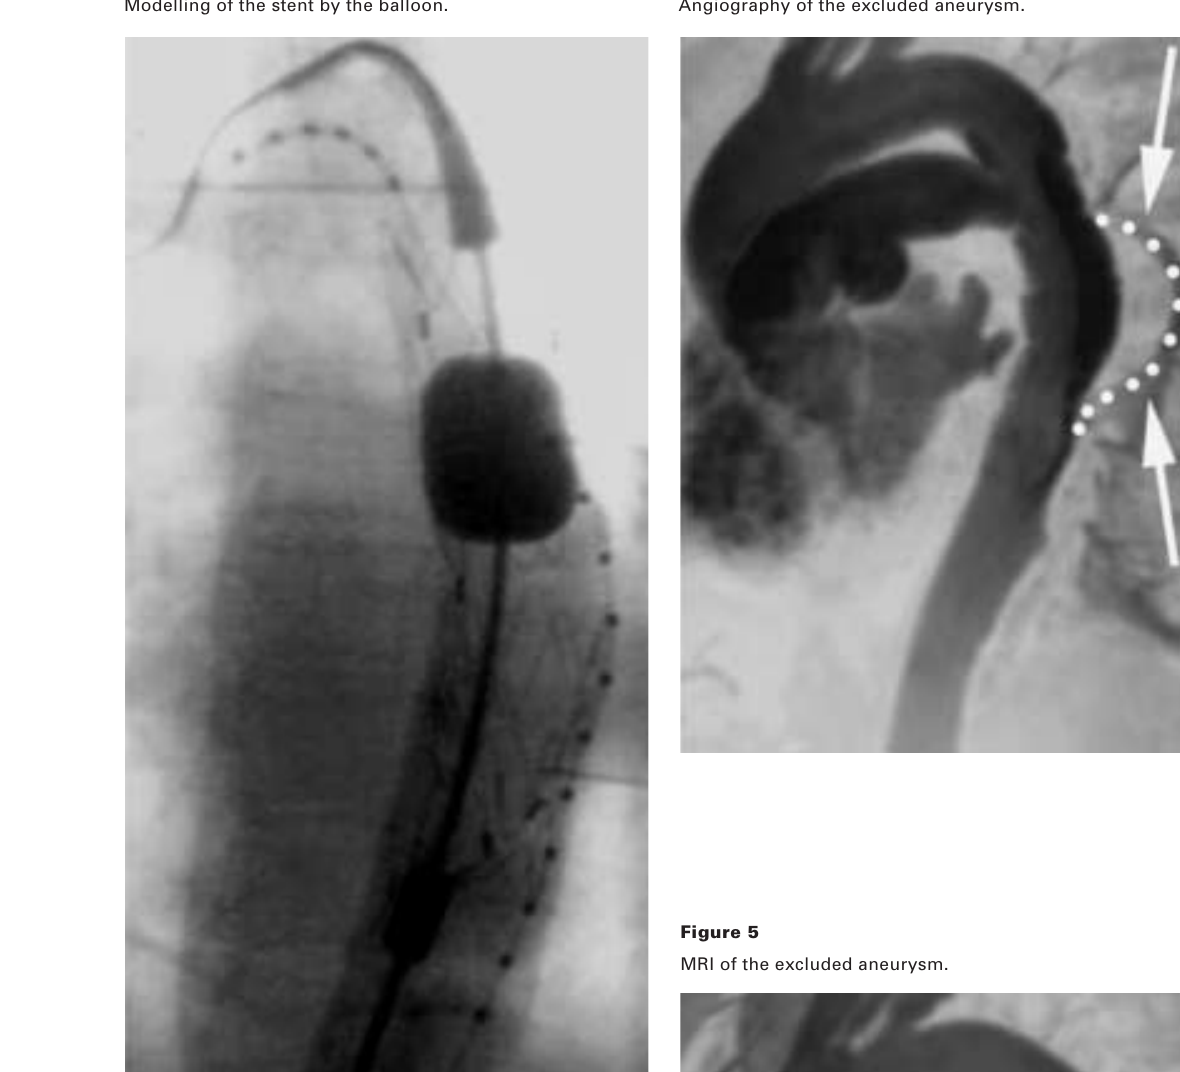
Modelling of the stent by the balloon. Angiography of the excluded aneurysm.